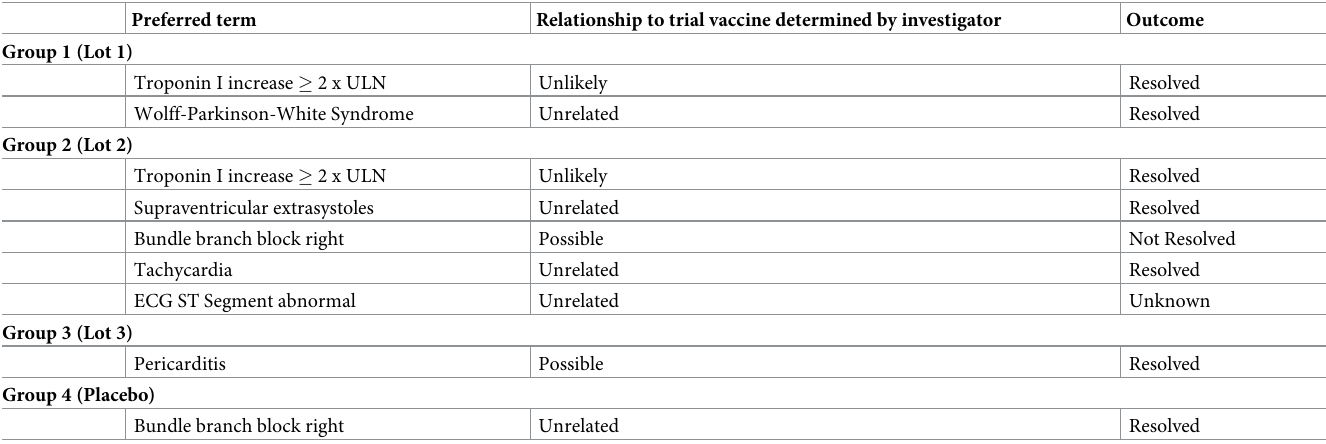
Table 3. Adverse events of special interest (FAS, n =